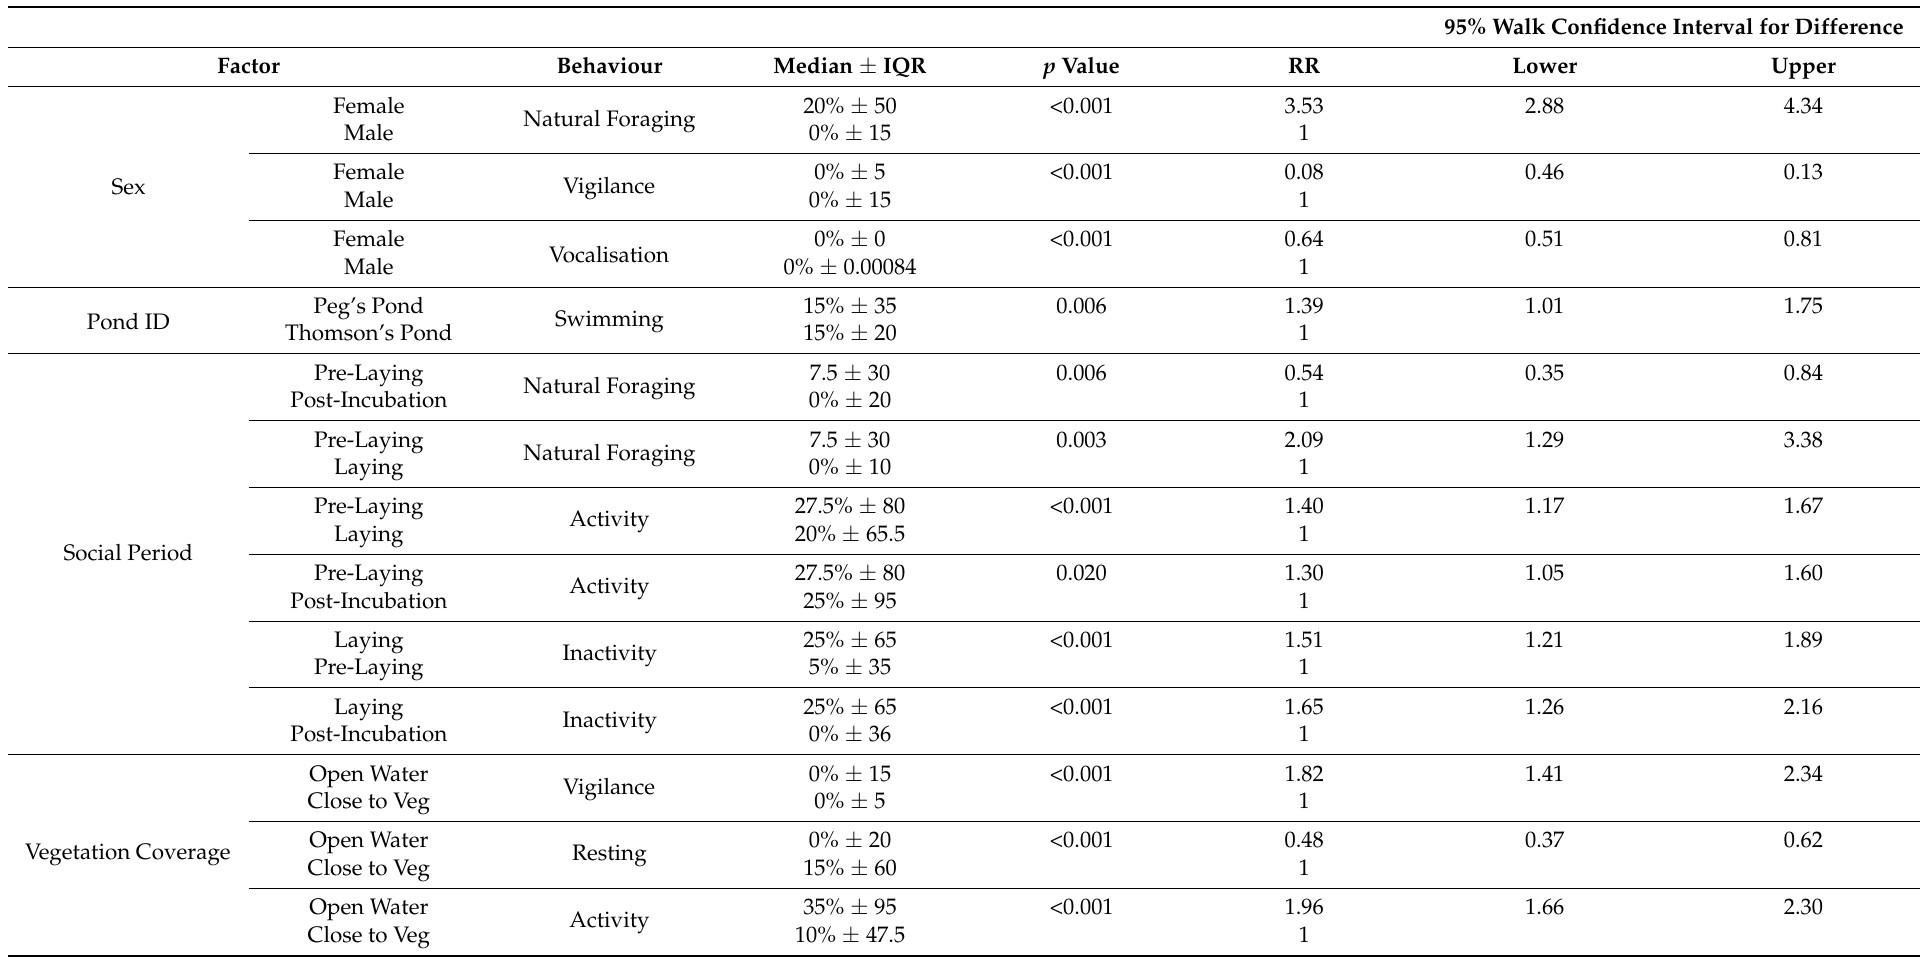
Table 2. Output of Generalised Estimating Equations including the Rate Ratios (RR) with 95% Confidence Intervals for significant factors and